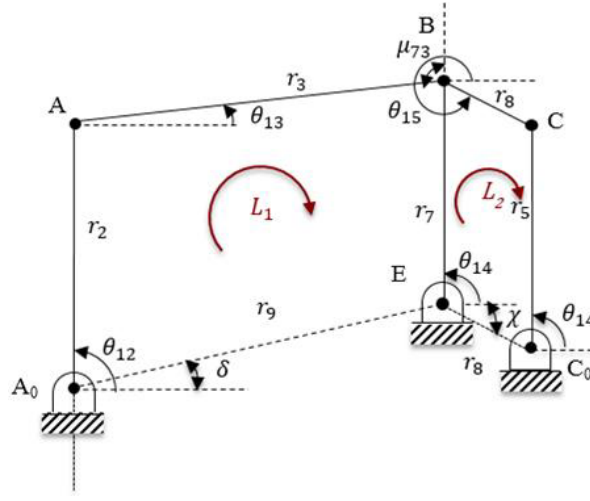
Figure 5. Structure parameters and variables for the cascade four- bar